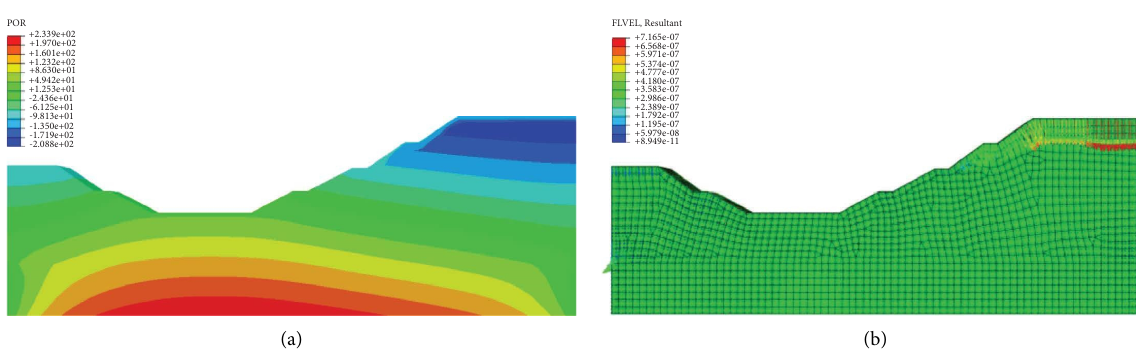
Figure 6: Seepage analysis under the infuence of rainfall. (a) Pore water pressure nephogram; (b) fow feld